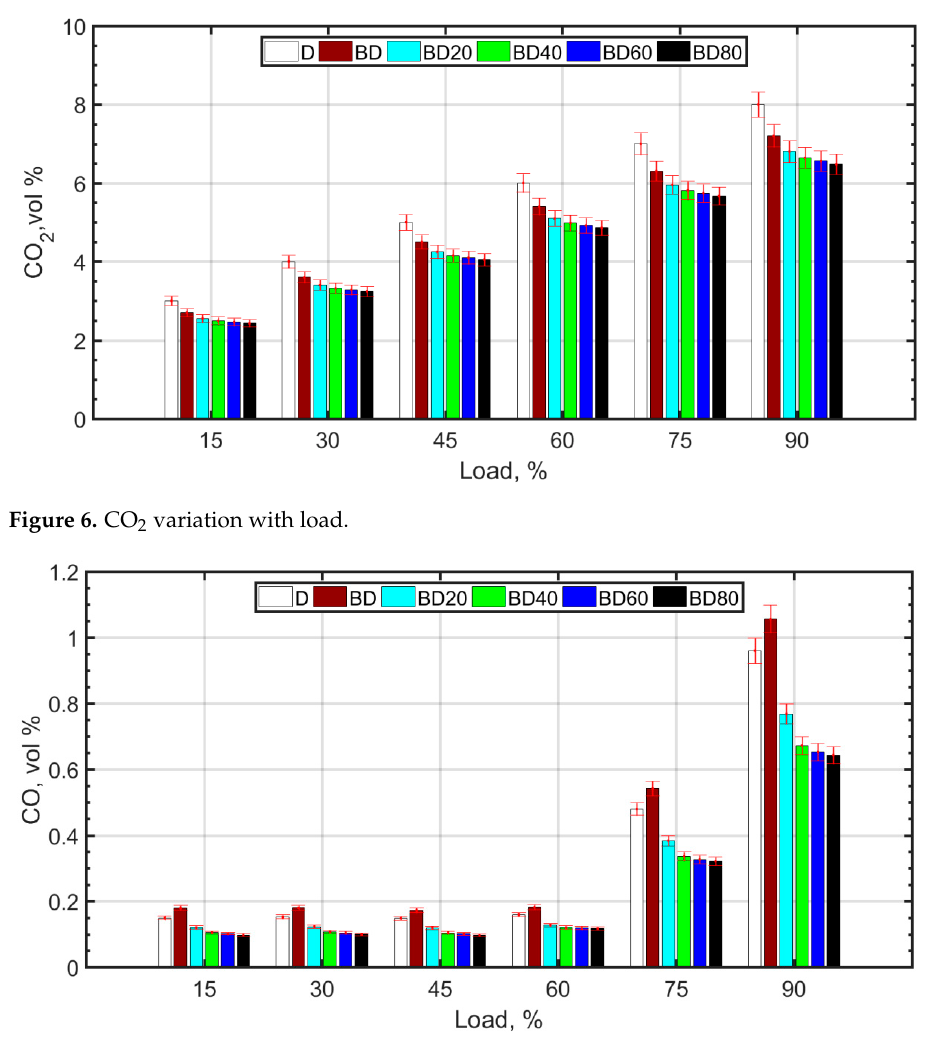
Figure 7. CO variation with load.